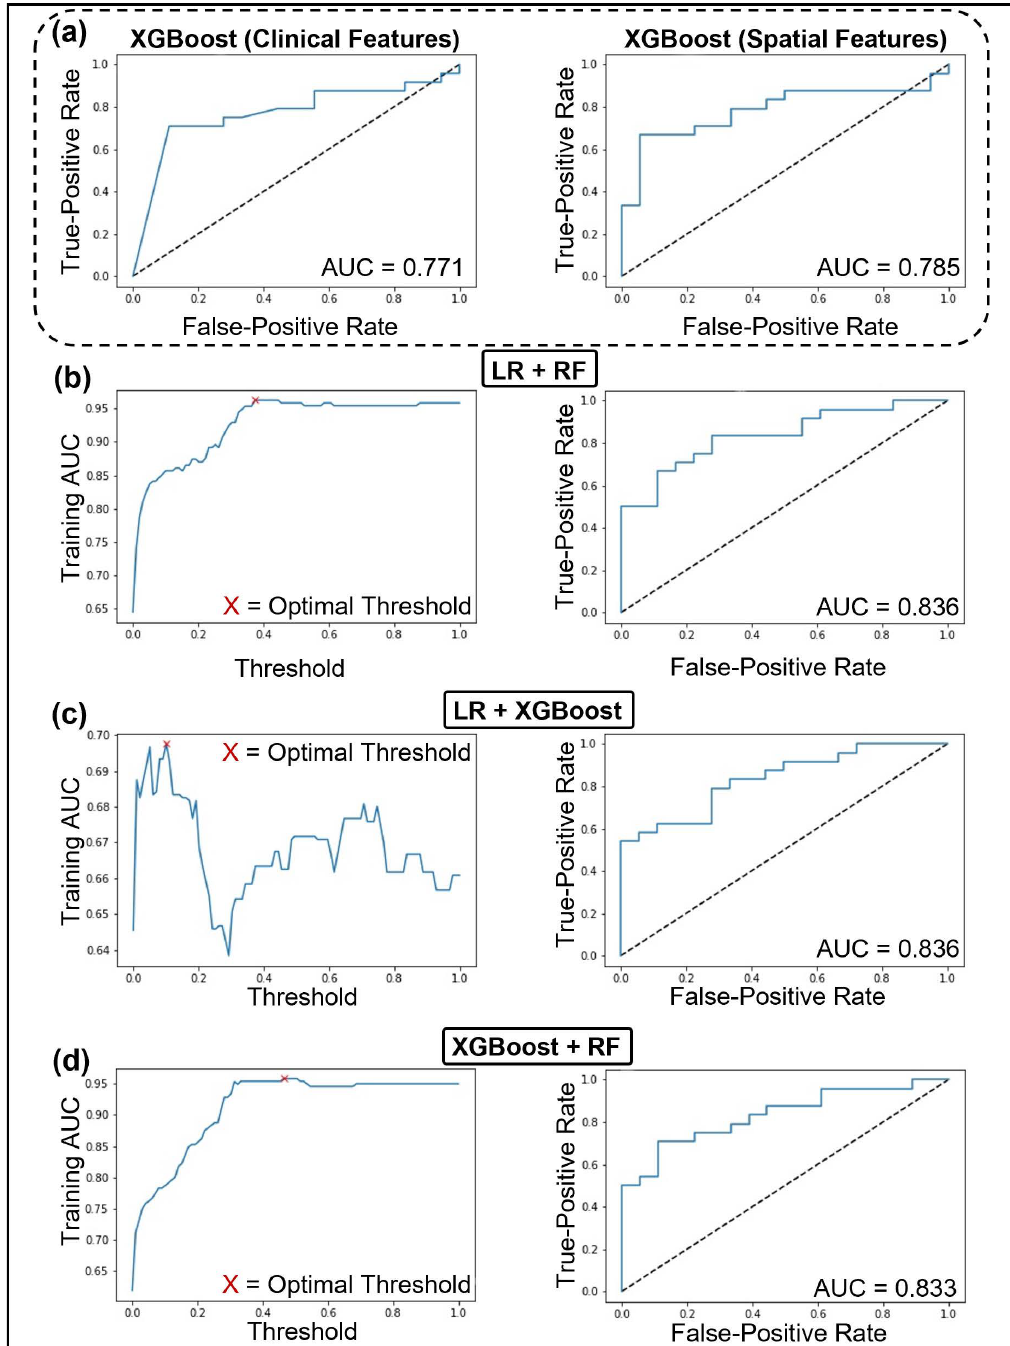
Figure 4. Receiver operating characteristics (ROC) curve and area under the curve (AUC) of the top performing machine learning models trained with clinical and spatial feature sets. ( a left) ROC and AUC of XGBoost, the top performing classifier using clinical features. ( a right) ROC and AUC of XGBoost, the top performing classifier using spatial features. ( b – d ) The top three performing ensemble models. ( b ) AUC vs. Threshold of LR+RF, with an optimal threshold of 37% (left). ROC and AUC of LR+RF (right). ( c ) AUC vs. Threshold of LR+XGBoost, with an optimal threshold of 10% (left). ROC and AUC of LR+XGBoost (right). ( d ) AUC vs. Threshold of XGBoost+RF, with an optimal threshold of 46% (left). ROC and AUC of XGBoost+RF (right). Abbreviations: ROC, Receiver Operating Characteristic curve; AUC, Area Under the Curve; LR, Logistic regression; RF, random forest classifier; XGBoost, Extreme Gradient